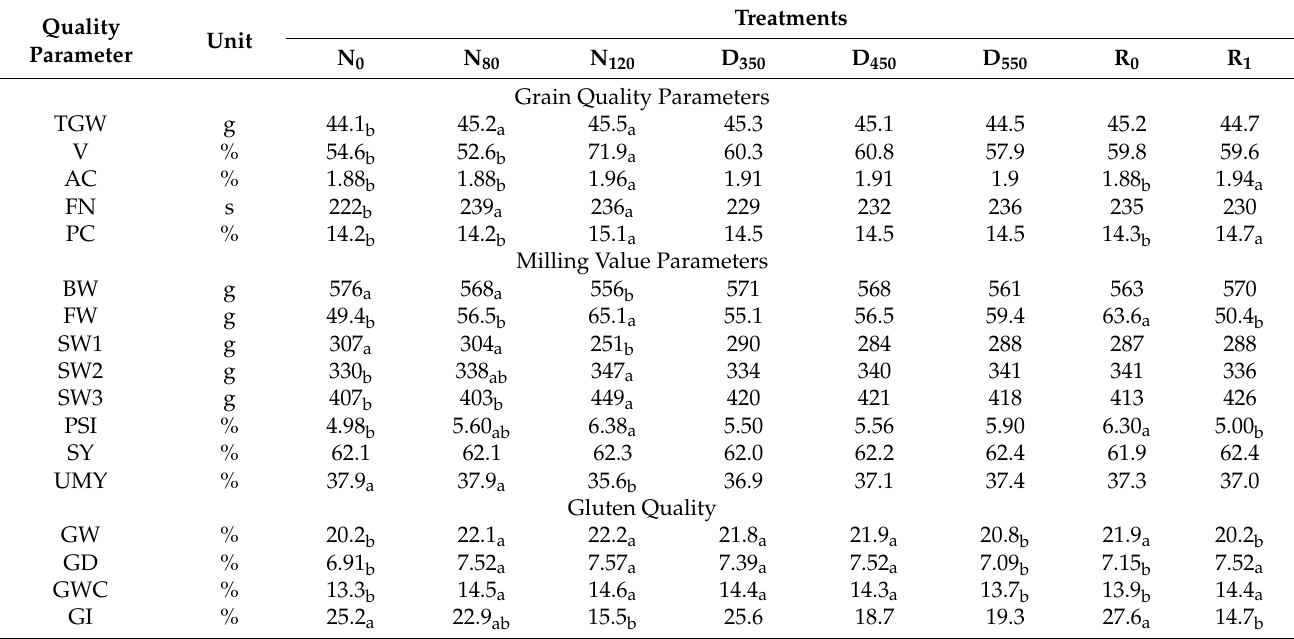
Table 3. Comparison of treatment means for grain quality and milling value parameters.